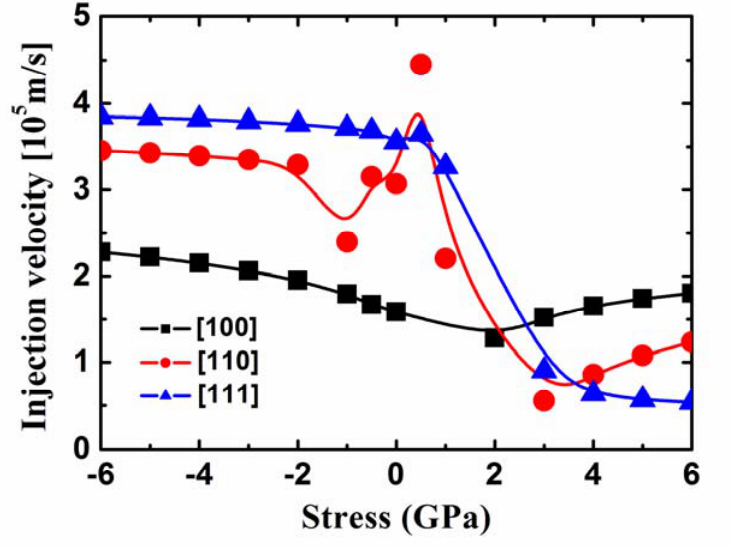
Figure 10. Injection velocity of the p-type 5 nm square SiNW FETs as a function of the stress.